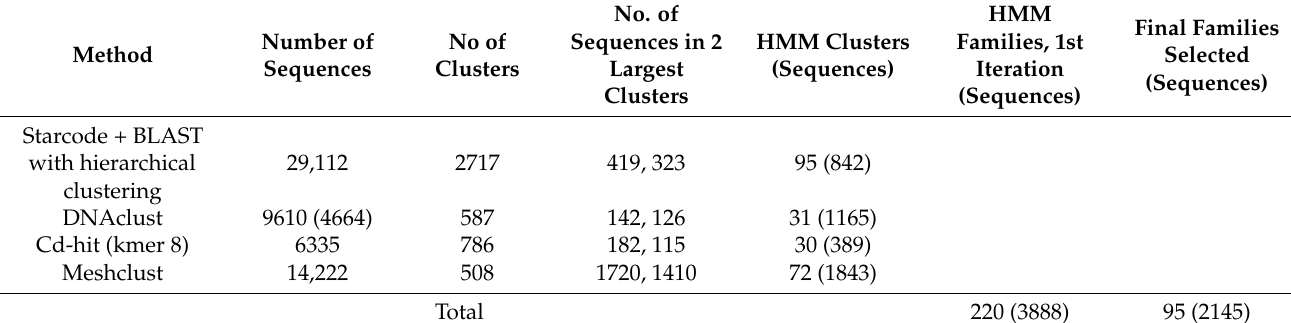
Table 1. Cluster summary based on different clustering